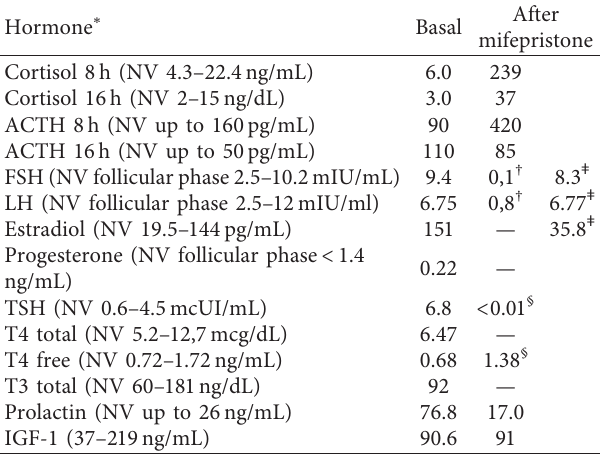
Table 2: Hormonal dosages before and during mifepristone use. Hormone ∗ Basal